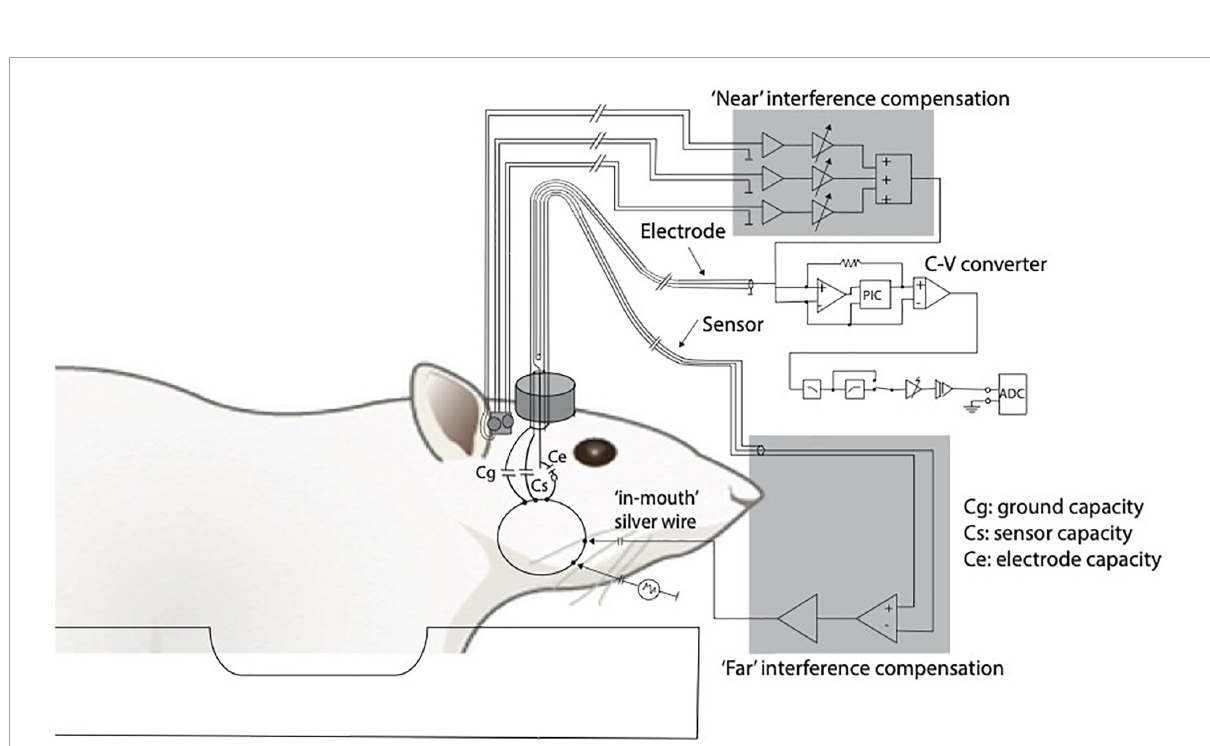
FIGURE2 Adapted from Logothetis et al. (2001). Diagram of the recording and compensation circuitry. The animal can be conceived as being capacitively connected to any metal contact, including connections to ground (Cg), sensor (Cs), and electrode (Ce). Because of the finite animal-to-ground capacity, a fraction of the interference currents flow through the electrode. To compensate for such currents, a sensor is built into the electrode holder (current sensor). Interference originating near the electrode tip or within the electrode holder and the cables is compensated for by using three small, orthogonally oriented identical coils positioned near the electrode (magnetic field sensor). C-V, current to voltage